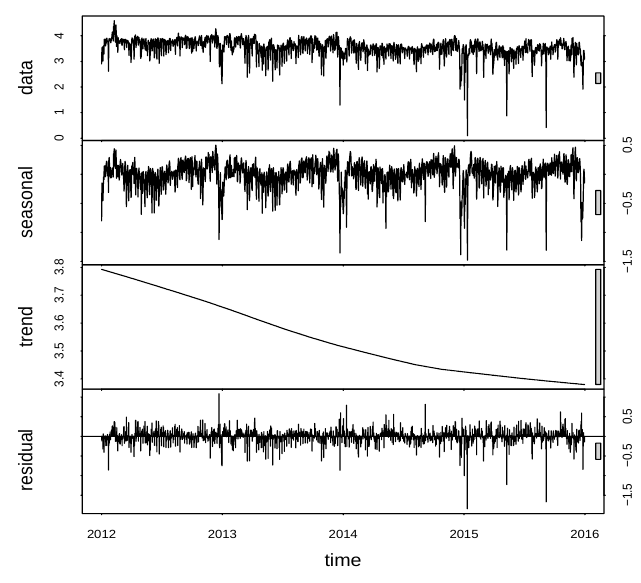
Figure 2. Decomposition of the electricity spot price time